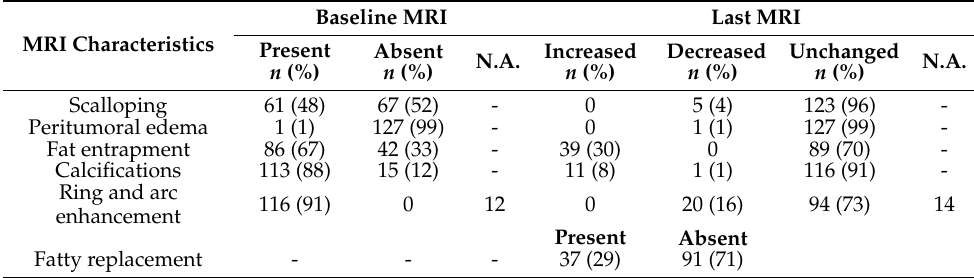
Table 2. MRI characteristics.